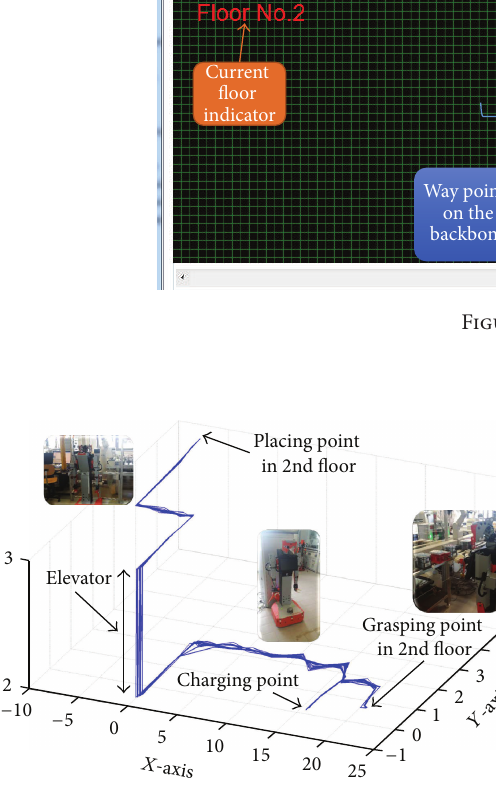
Figure 11: The real mobile robot transportation path on multifloor (repeating ten